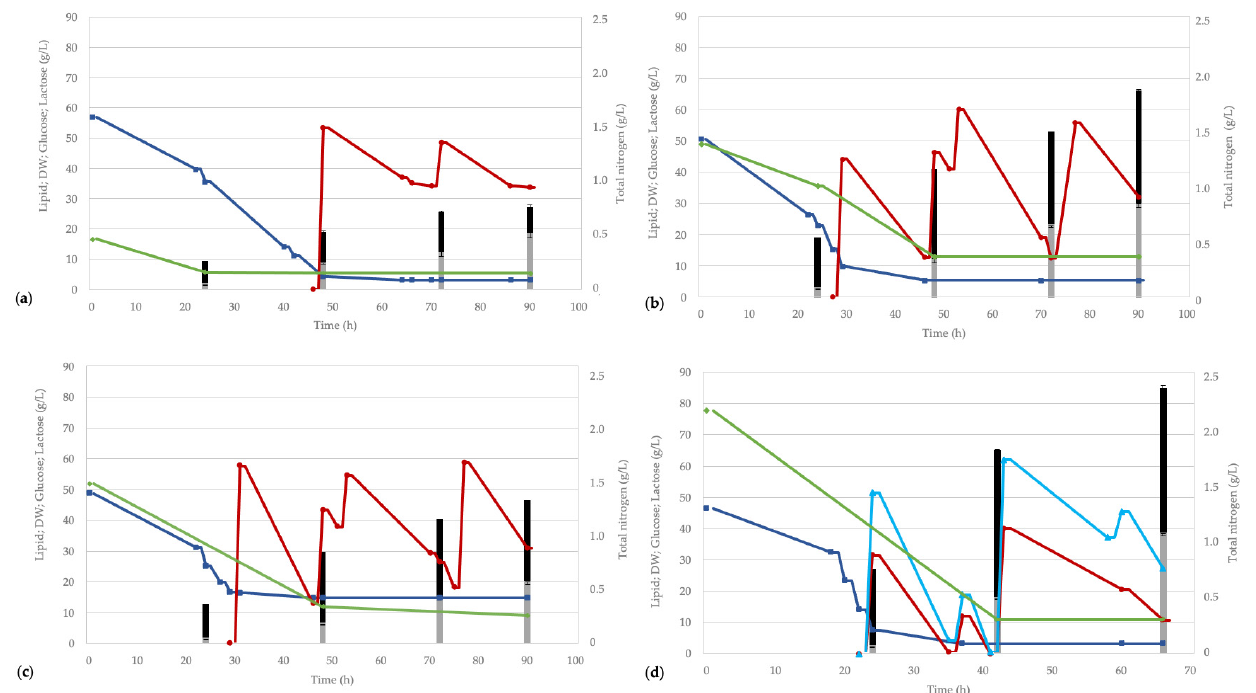
Figure 5. Main parameters of ATCC 20509 processes in WPYE ( a ), WPYEU ( b ), WPUC ( c ), and WPYU+M ( d ). Black bar = dry weight (DW, g/L); gray bar = lipid concentration (g/L); green line = residual nitrogen (g/L); blue line = residual lactose (g/L); red line = residual glucose (g/L); light blue line = residual fructose (g/L).